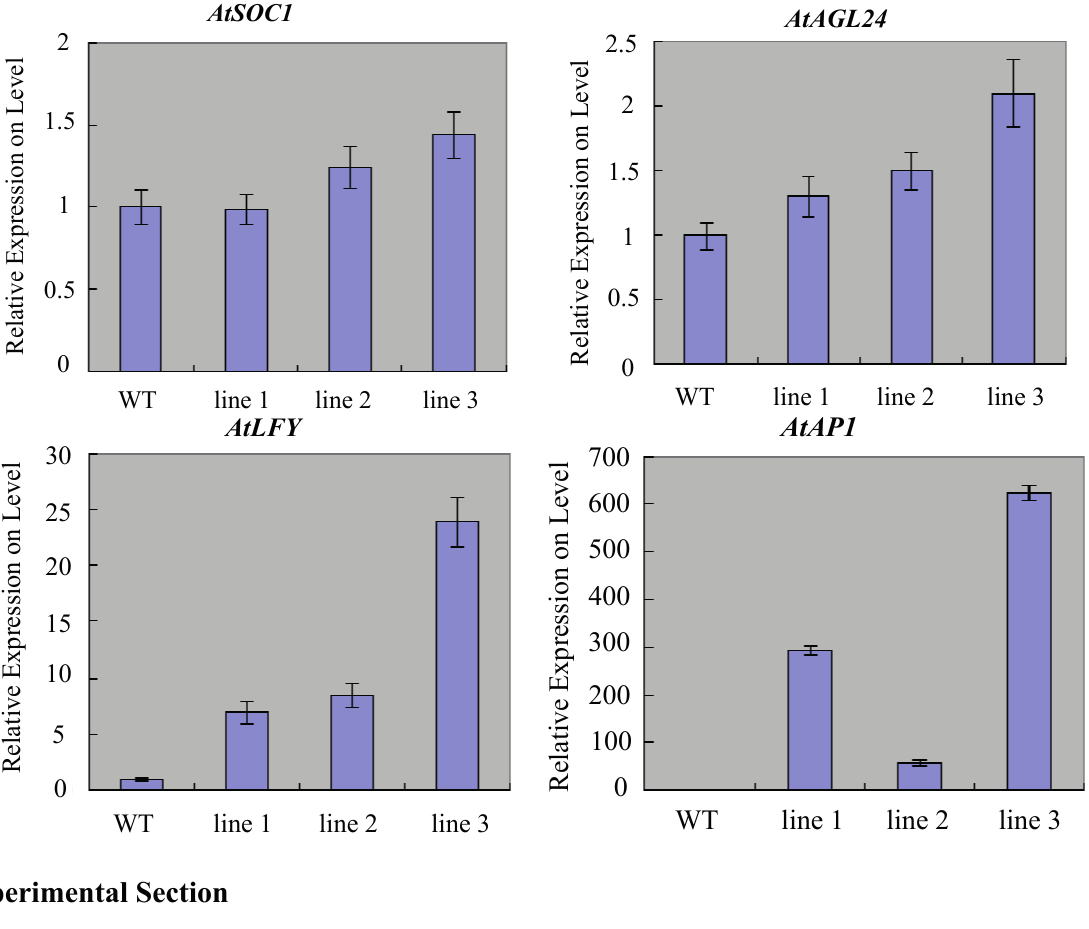
Figure 5. Expression patterns of AtAGL24 , AtSOC1 , AtLFY and AtAP1 using qRT-PCR in wild-type and transgenic seedlings. The expression level of AtActin2 was used as an internal reference. Values represent the means, and the error bars represent standard errors for three independent